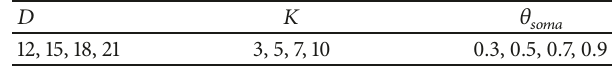
Table 3: Parameter levels in EPNN of the Distress credit data